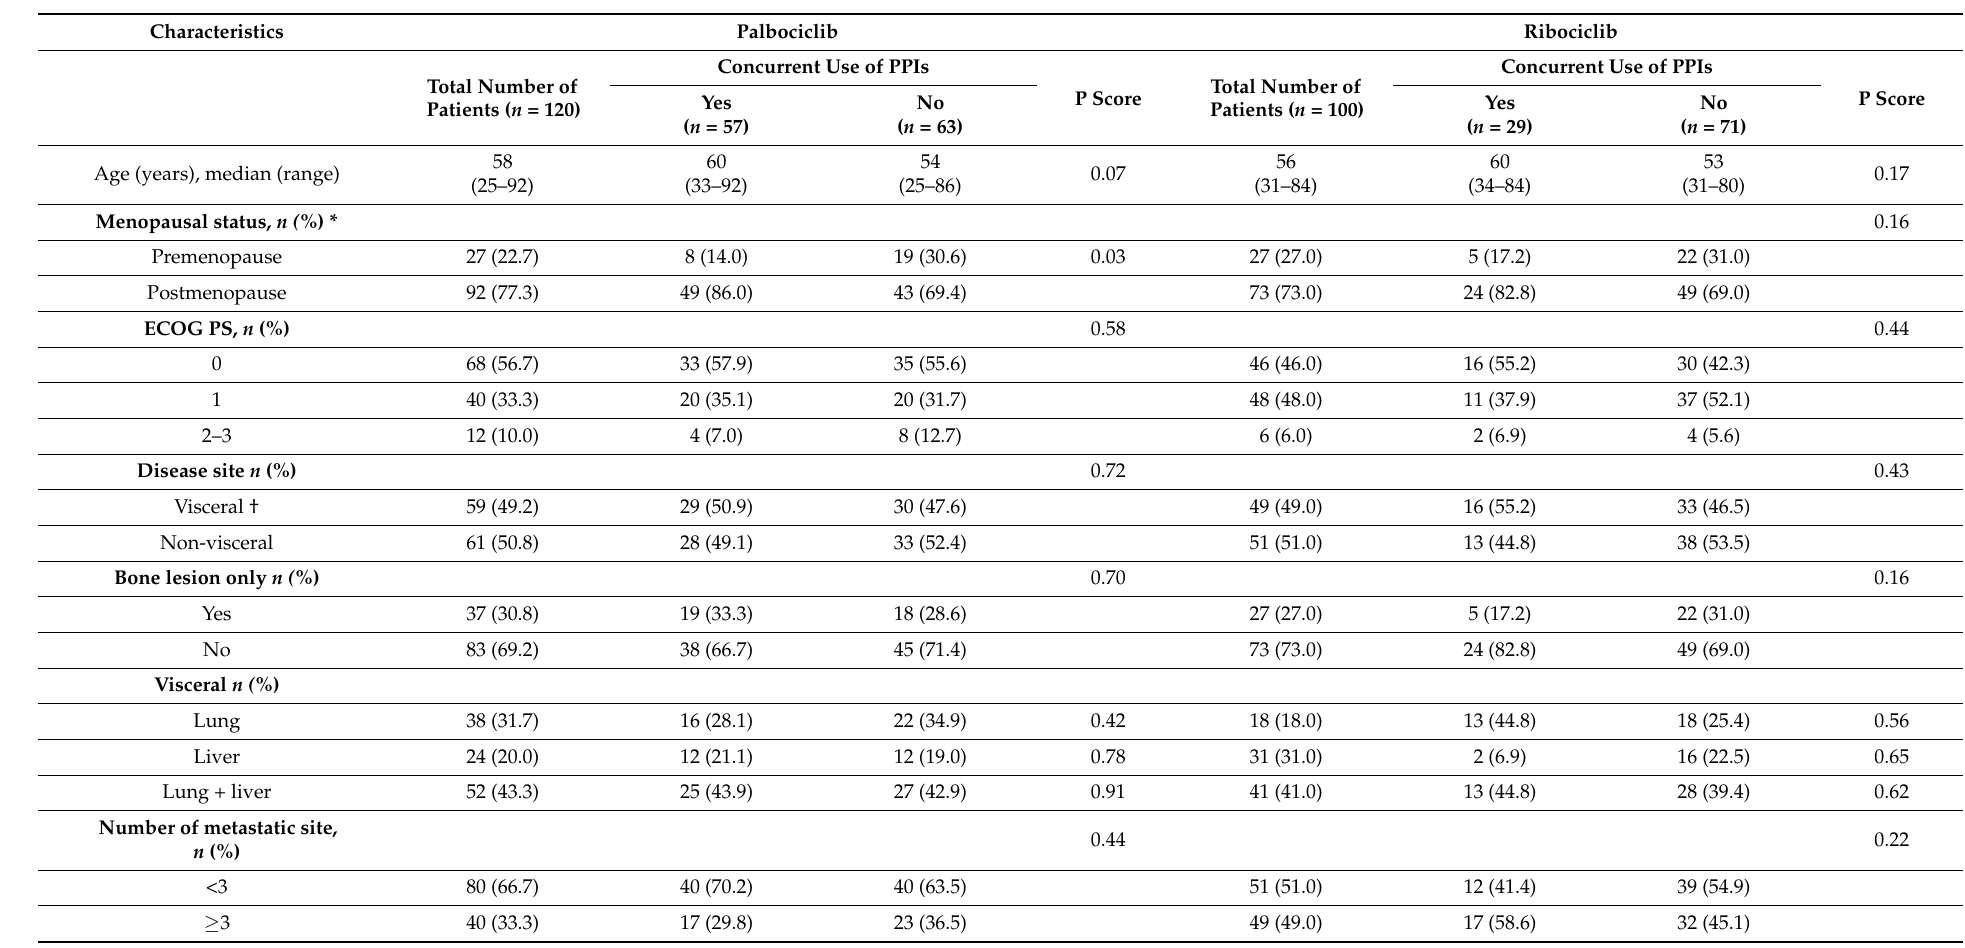
Table 1. Clinical characteristics of patients and their distribution across PPI